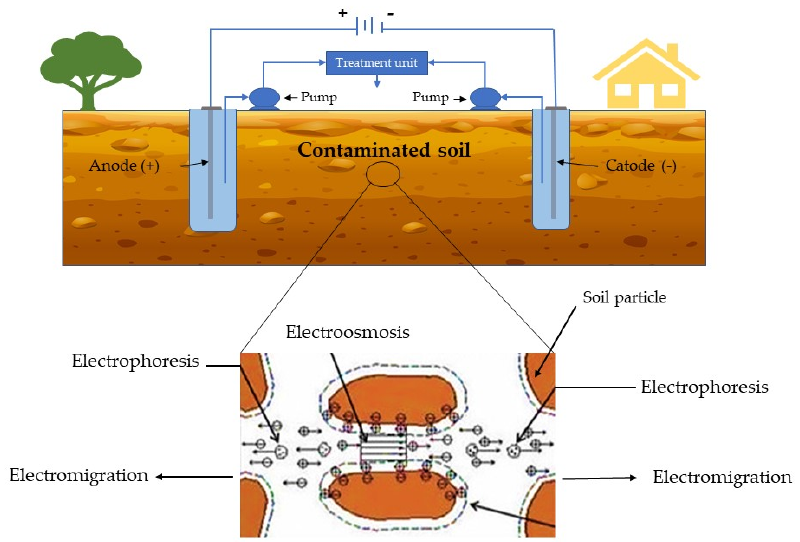
Figure 4. Electrochemical remediation scheme.